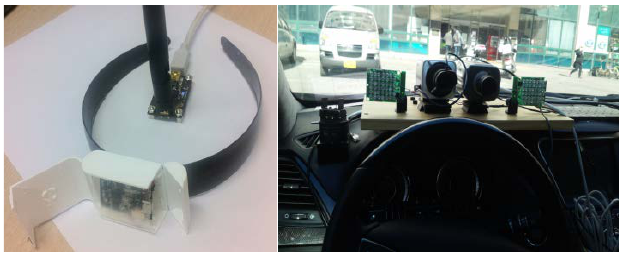
Figure 8. A wireless gyro-sensor module mounted in a white box and its receiver ( left ), and cameras and other setup installed in the vehicle ( right ). Appl. Sci. 2016 , 6 , 137